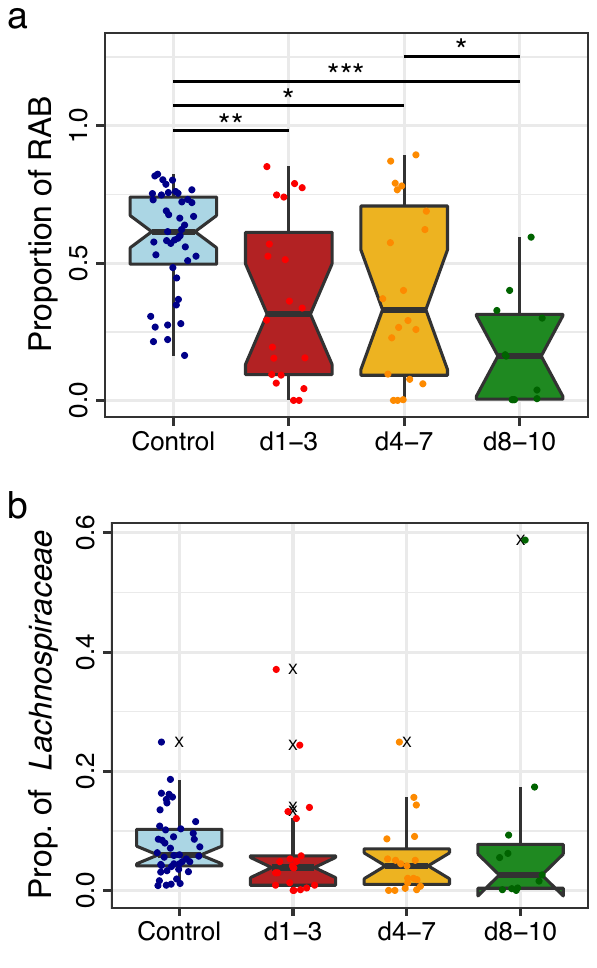
Figure 4. Relative abundance of recovery associated bacteria (RAB) and Lachnospiraceae . ( a ) Proportion of RAB present in microbiomes. Patient samples from day 1–3, day 4–7 and days 8–10 were significantly reduced from the median level of the control group. RAB at days 8–10 were also significantly reduced from the median RAB level at day 4–7. ( b ) Proportion of Lachnospiraceae present in microbiomes. No significant difference was observed between groups after controlling for multiple comparisons. Conover-Iman significance *** p ≤ 0.001, ** p ≤ 0.01, * p ≤ 0.05, p > 0.05 = not